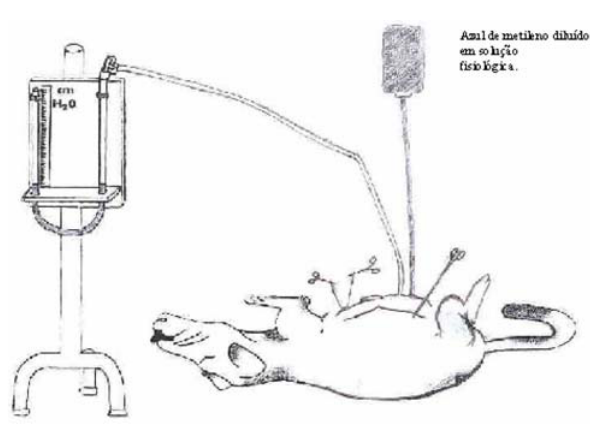
FIGURA 3: Demonstração do processo de medição do refluxo colo-ileal, evidenciando o manômetro de água, com as colunas de água e de azul de metileno e os cateteres colônicos. Modificado de Gieburowski 17,18 .